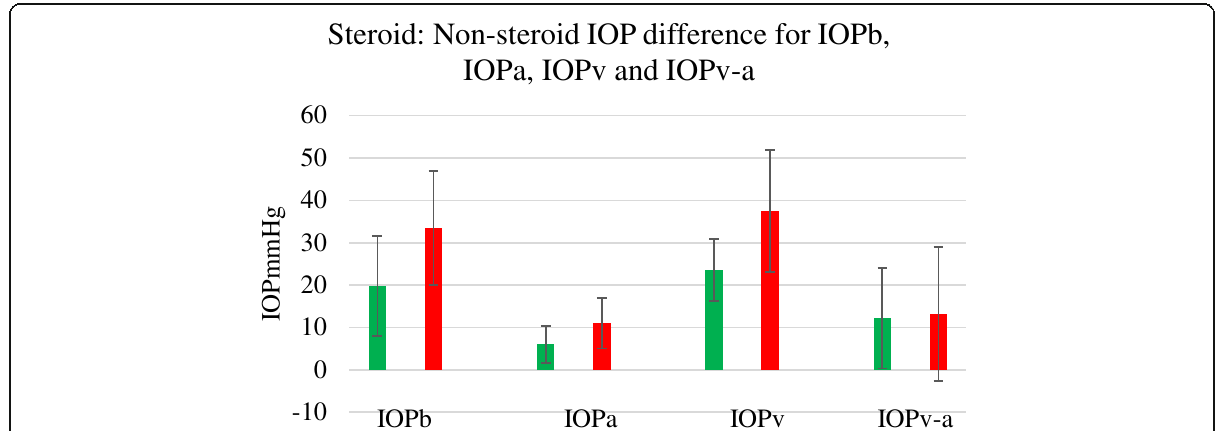
Fig. 3 Steroid treated subjects had higher IOPb ( p < 0.002), IOPa ( p < 0.03) and IOPv ( p < 0.05) pressure than the non-steroid treated controls. N